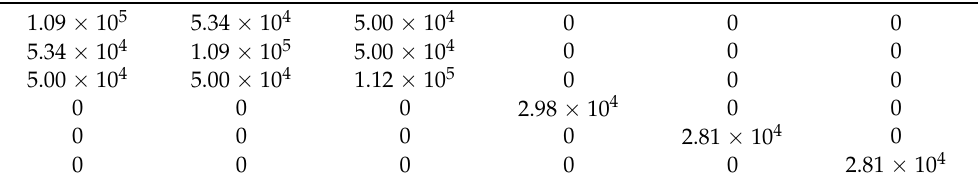
Table 3. The stiffness matrix, C 2 (MPa), of the EAS-Nb 3 Sn level 2 homogeneous superconducting region at T = 4 K, ε =